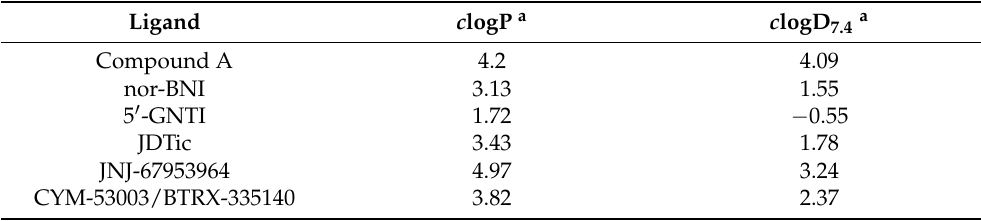
Table 4. Calculated logP and logD 7.4 of Compound A and various small molecules KOR antagonists. Ligand c logP a c logD 7.4 a Compound